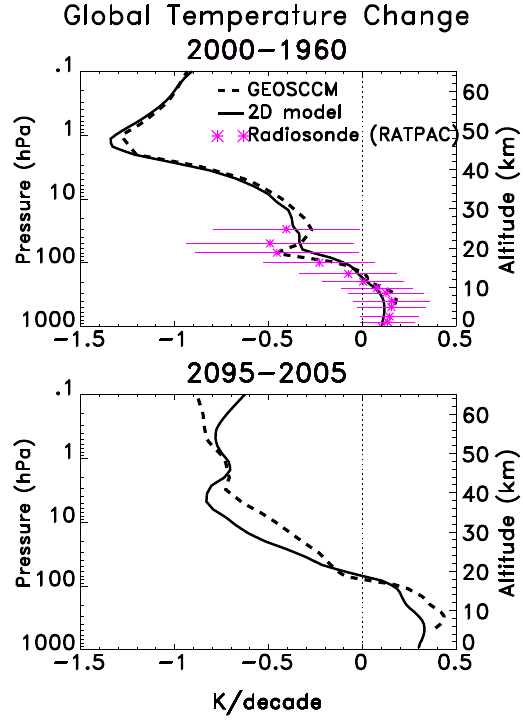
Fig. B3. As in Fig. B2, except for the global (90 ◦ S–90 ◦ N) average profiles for the GEOSCCM (black dashed) and 2D model (black solid). The top panel includes the trend derived from radiosonde Figure B2. (Top panels) Annually averaged temperature trend for 2000–1960 from the GEOSCCM Fig. B2. (Top panels) Annually averaged temperature trend for Figure B3. As in Fig. B2, except for the global (90 ◦ S–90 ◦ N) average profiles for the GEOSCCM data (RATPAC-A, pink asterisks) (Free et al., (left) and 2-D model (right) base simulations (all source gases varied time dependently). The trends are 2000–1960 from the GEOSCCM (left) and 2-D model (right) base (black dashed) and 2D model (black solid). The top panel includes the trend derived from radiosonde derived from linear least squares fits to the annually averaged time series. (Bottom panels) As in the top simulations (all source gases varied time dependently). The trends are derived from linear least squares fits to the annually averaged panels except for the 2095–2005 temperature difference (K decade − 1 ) using 10-year averages centered data (RATPAC-A, pink asterisks) (Free et al., 2005). time series. (Bottom panels) As in the top panels except for the on 2095 and 2005 to reduce the effects of interannual dynamical variability in the GEOSCCM. The 2095–2005 temperature difference (Kdecade − 1 ) using 10-yr aver- contour intervals are − 0.2 and +0.1 K decade − 1 and include the − 0.1 and − 0.3 contours. The dashed ages centered on 2095 and 2005 to reduce the effects of interannual contours indicate negative values. 66 dynamical variability in the GEOSCCM. The contour intervals are − 0.2 and +0.1Kdecade − 1 and include the − 0.1 and − 0.3 contours. 67 The dashed contours indicate negative values.